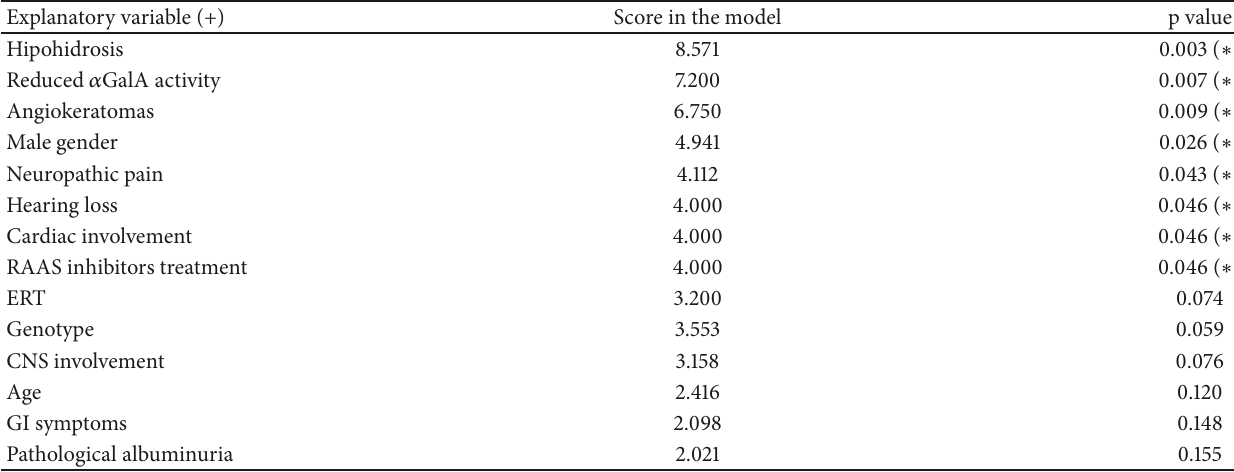
Table 3: Binary logistic regression model to predict the appearance of urinary microRNAs excretion profile indicative of renal fibrosis in Fabry disease patients.